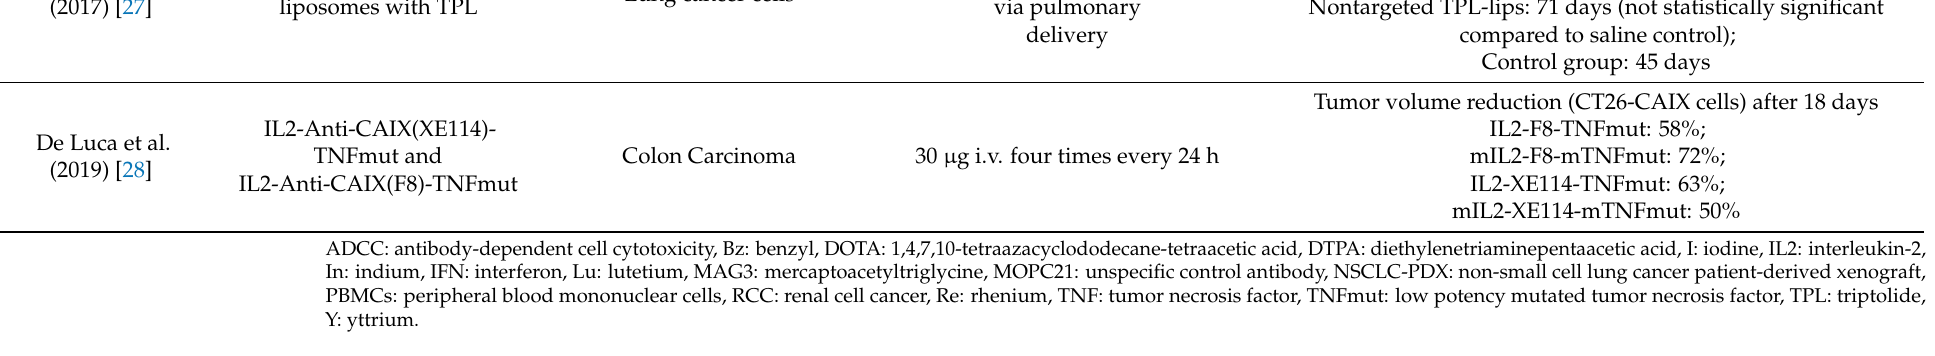
Table 2. Anti-CAIX monoclonal antibodies-based clinical trials reporting antitumor responses and adverse effects on renal cell